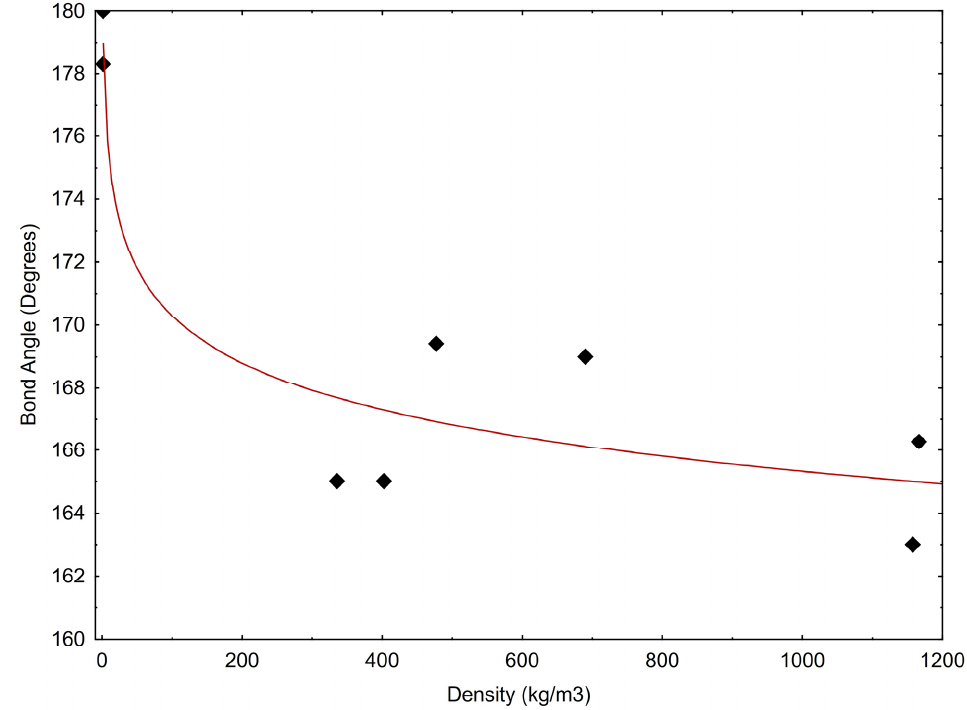
Figure 5. CO 2 bond angle versus density. Data are from Table 1.